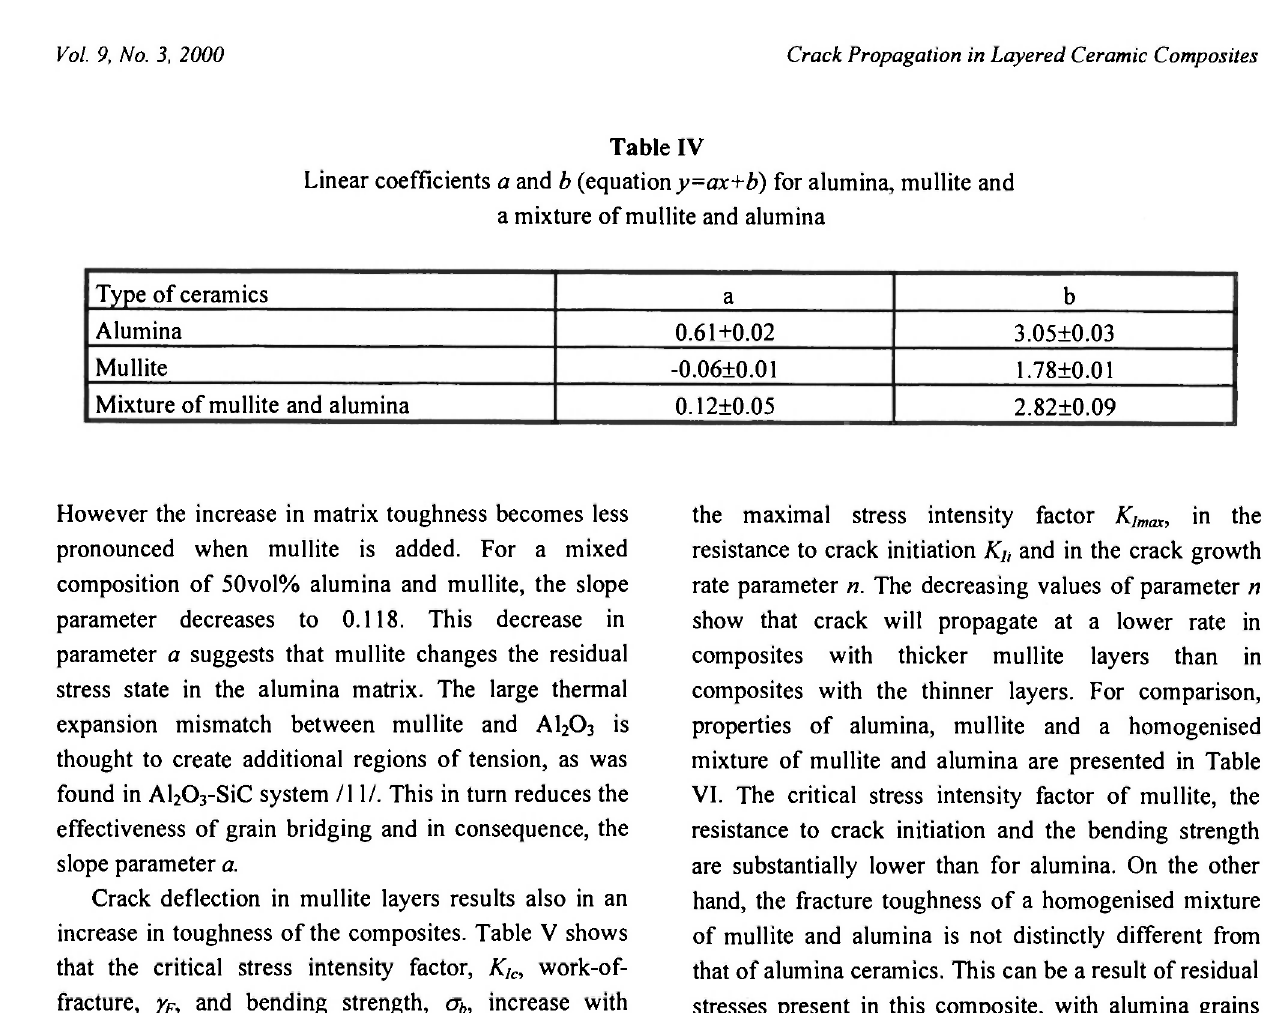
Mechanical properties of layered composites of alumina and mullite as a function of barrier layer thickness and composition